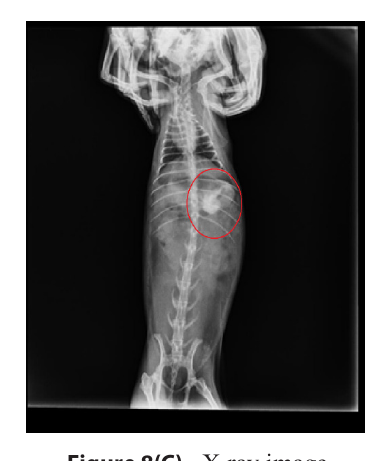
Figure 8(C) - X-ray image Rabbit at 2h of.